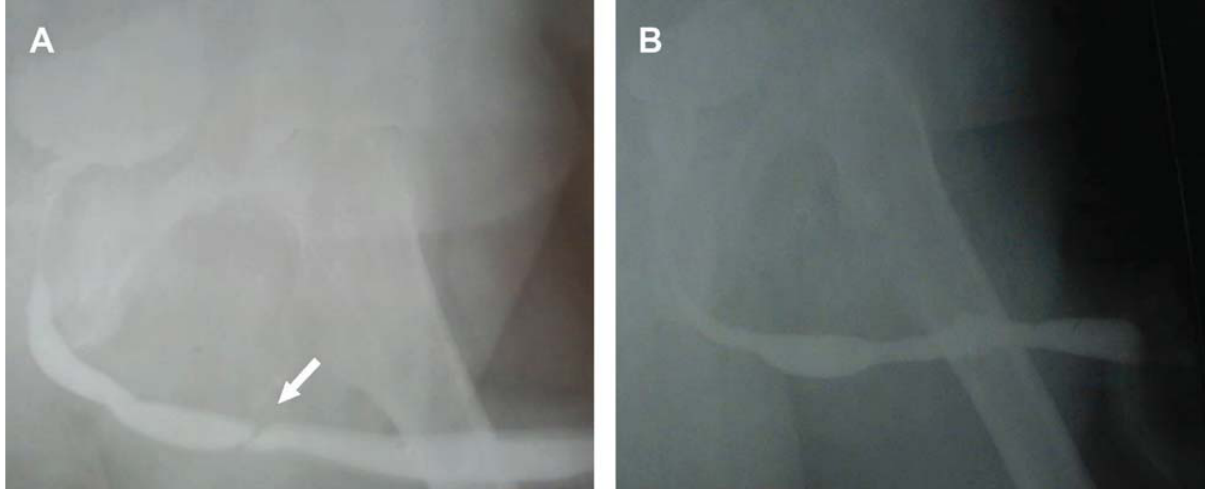
Figure 2 – A)- Preoperative urethrography showing urethral stricture (arrowhead). B)- Postoperative urethrography showing widely patent urethra after bipolar